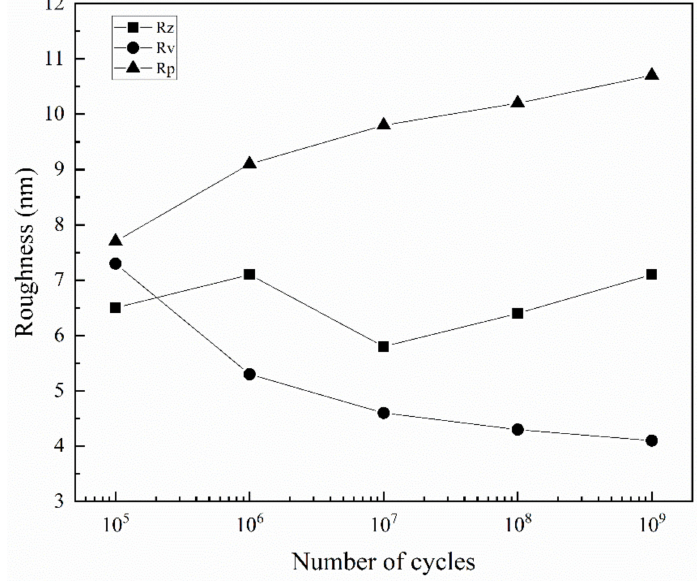
Figure 7. Variation of the roughness of slip band 2. ( σ = 322